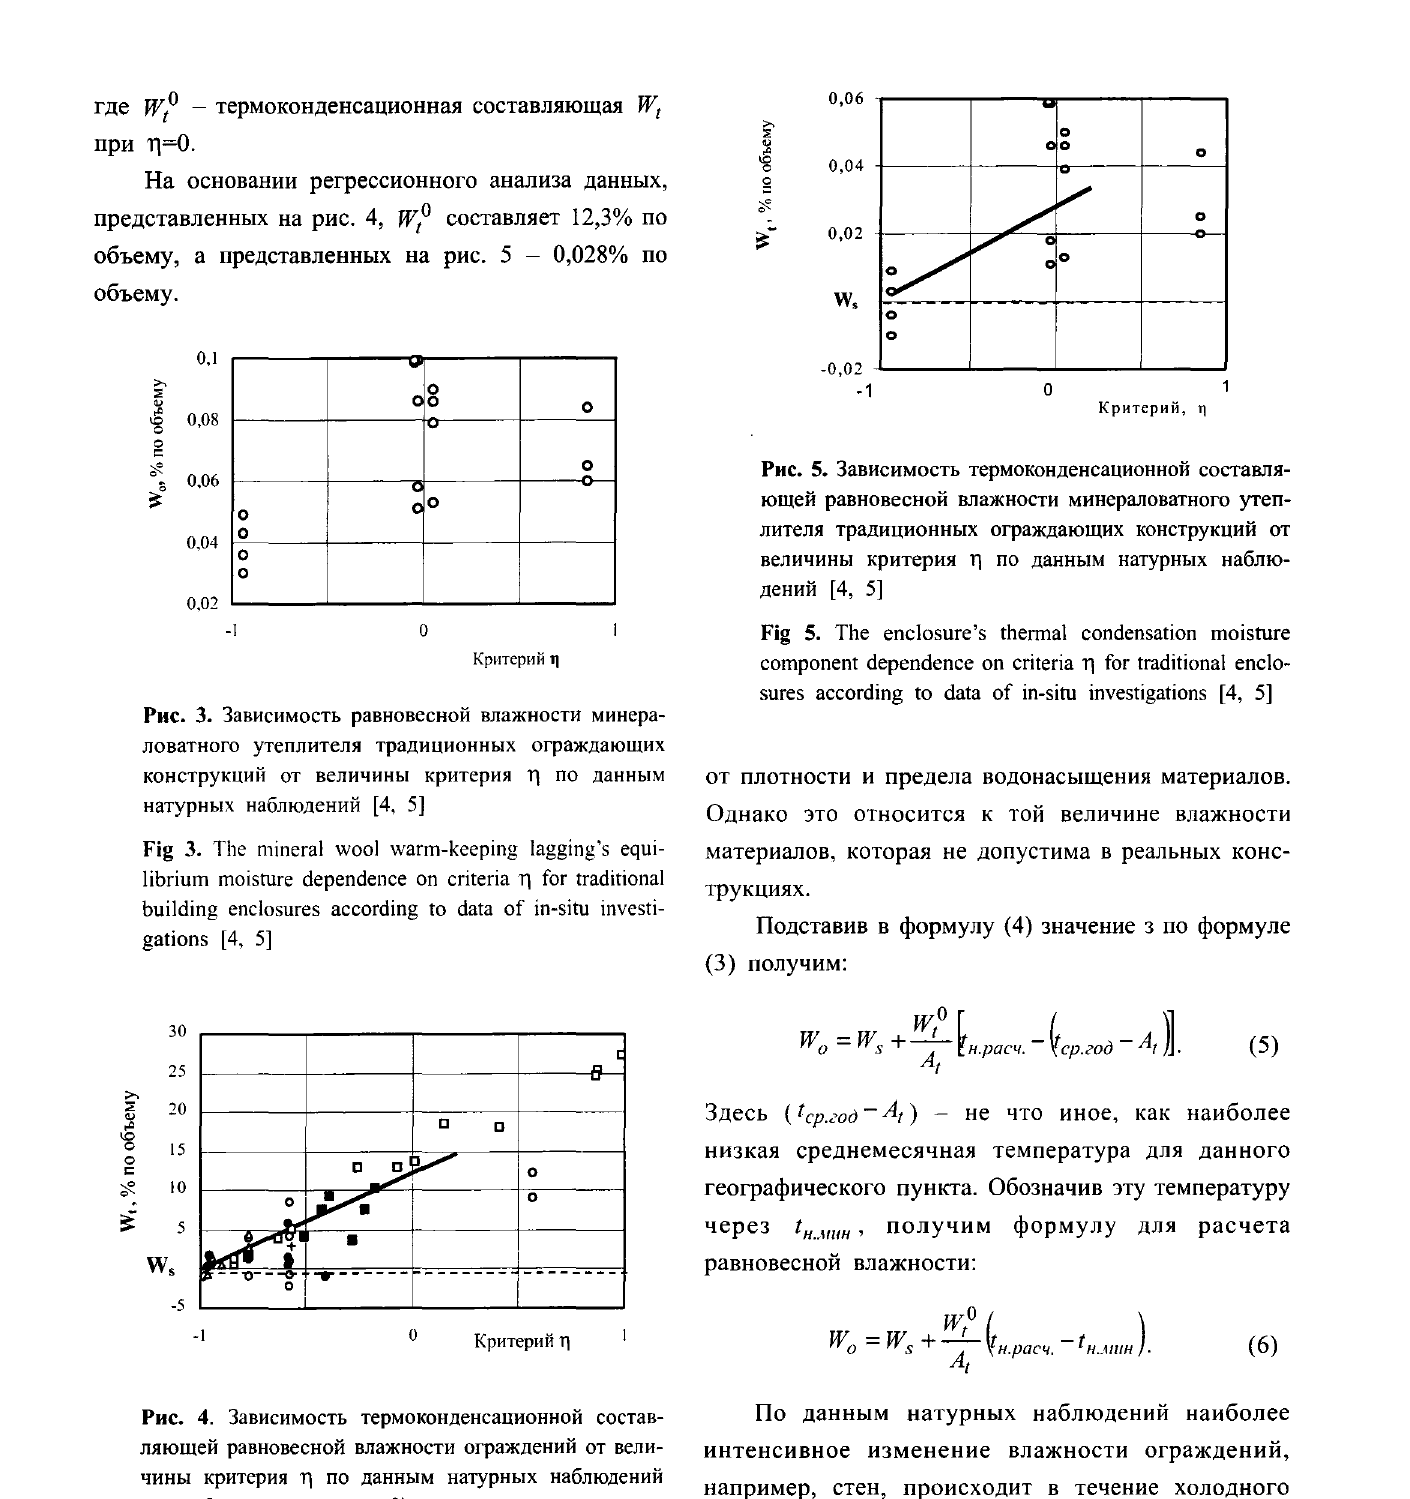
Fig 3. The mineral wool warm-keeping lagging's equi librium moisture dependence on criteria 11 for traditional building enclosures according to data of in-situ investi gations [4, 5]